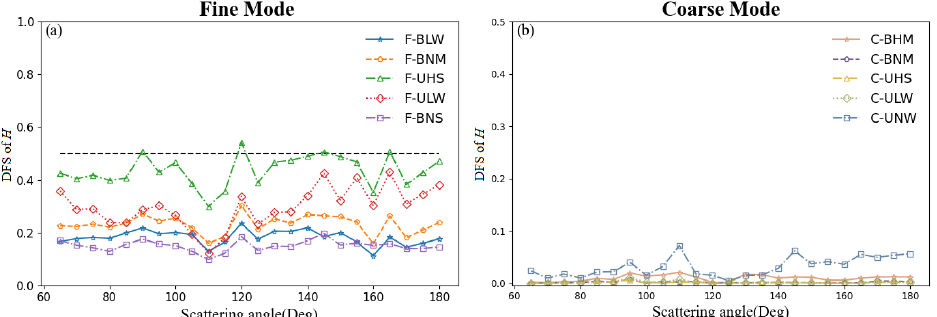
Figure 9. The DFS of H as a function of the scattering angle with single-angle polarization observa- tions. ( a ) represents fine aerosol model types and ( b ) represents coarse aerosol model types.